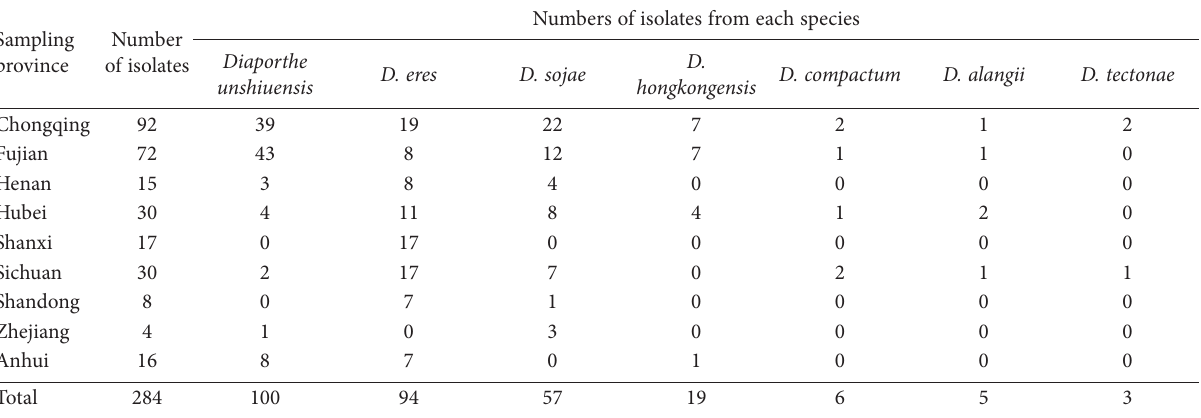
Table 2. Sampling regions and numbers of Diaporthe isolates obtained in this study.